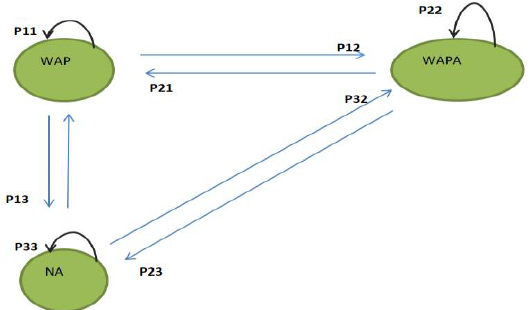
Figure 4. Possible transitions between WAP, WAPA, NA states for customers.